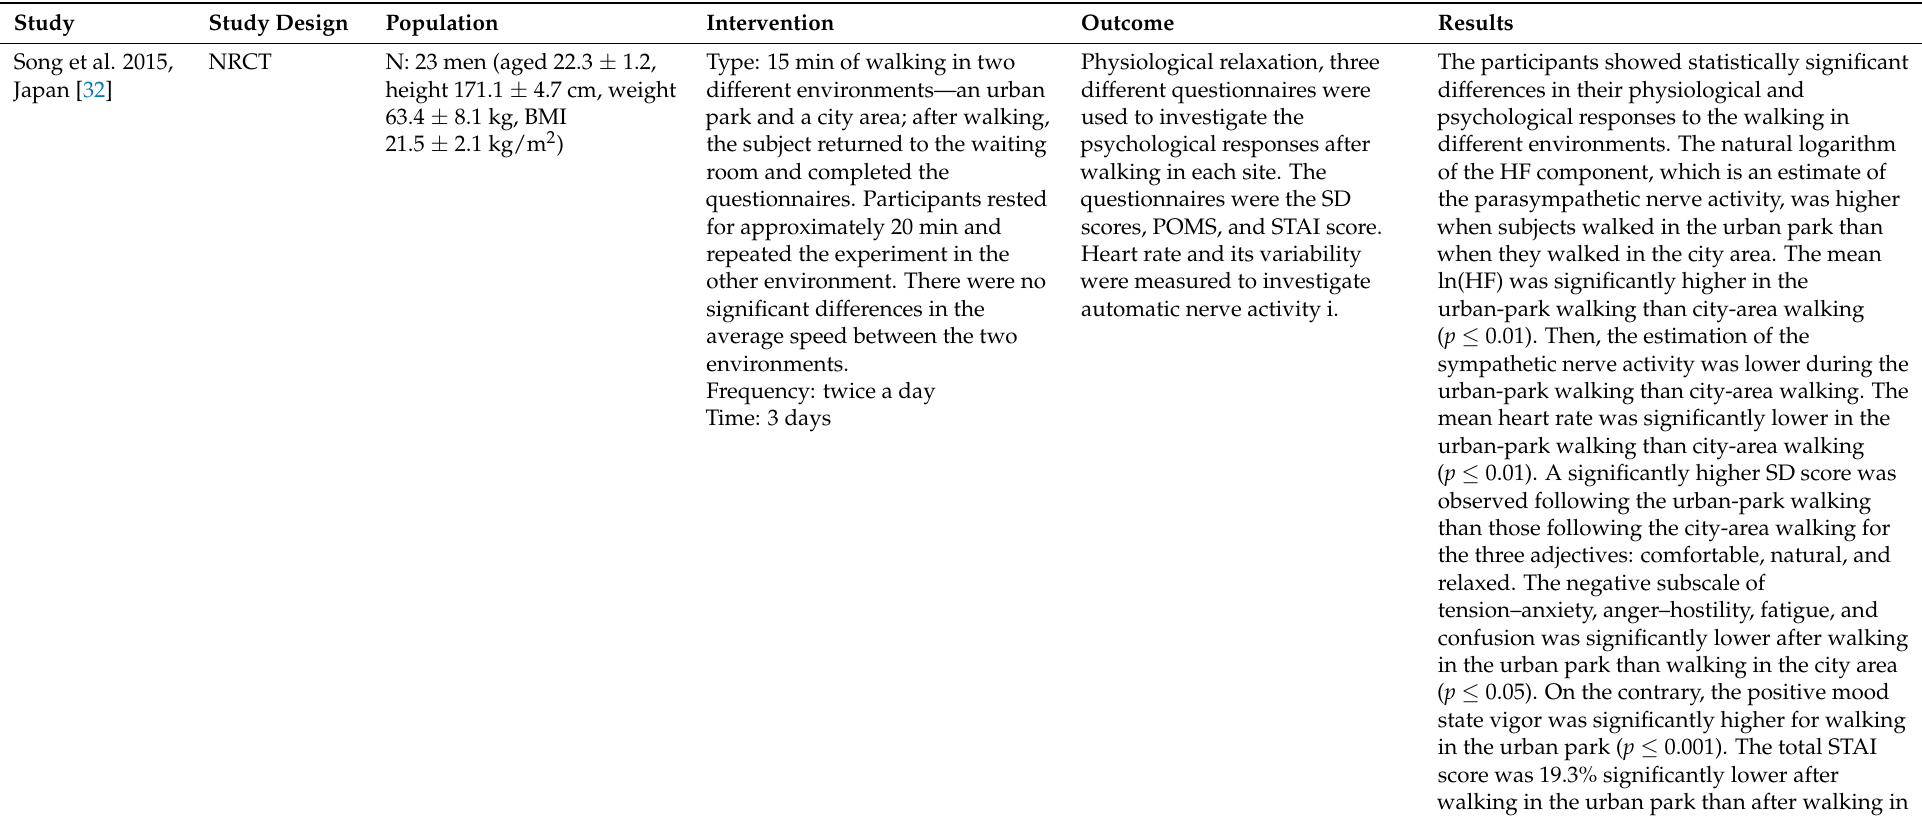
Table 3. Characteristics of studies